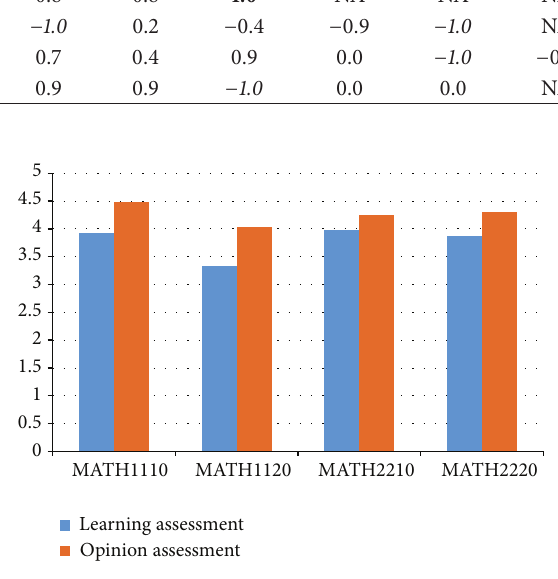
Figure 3: Overall average score for the outcomes of all math courses based on learning and opinion